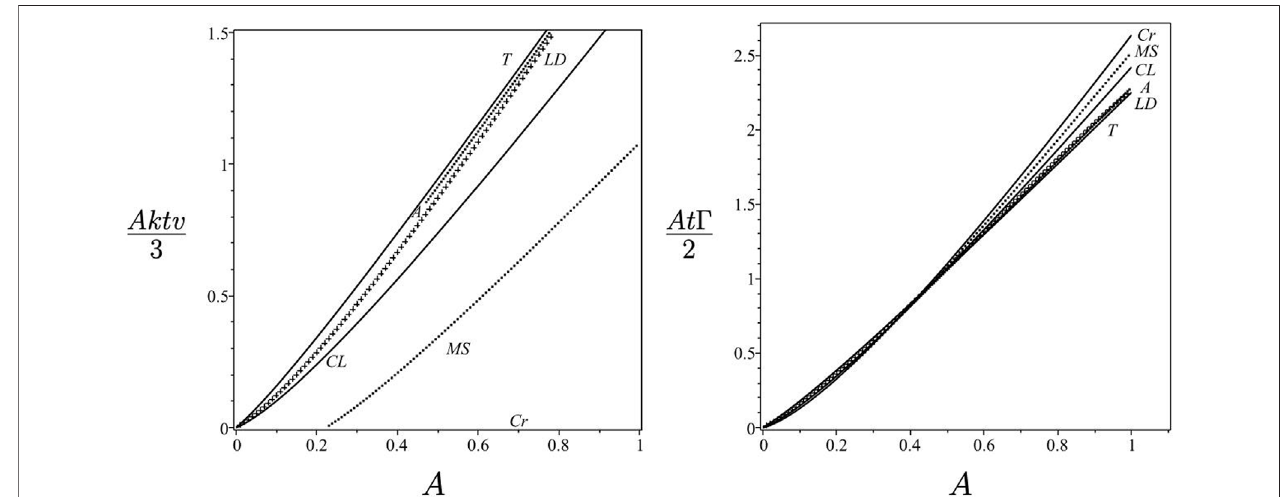
FIGURE8| VelocityandshearfunctionasfunctionsoftheAtwoodnumberforthecritical(Cr),convergence-limit(CL),Taylor(T),minimum-shear(MS),Layzer-drag (LD) and Atwood (A) bubbles bubbles for kG (cid:1)